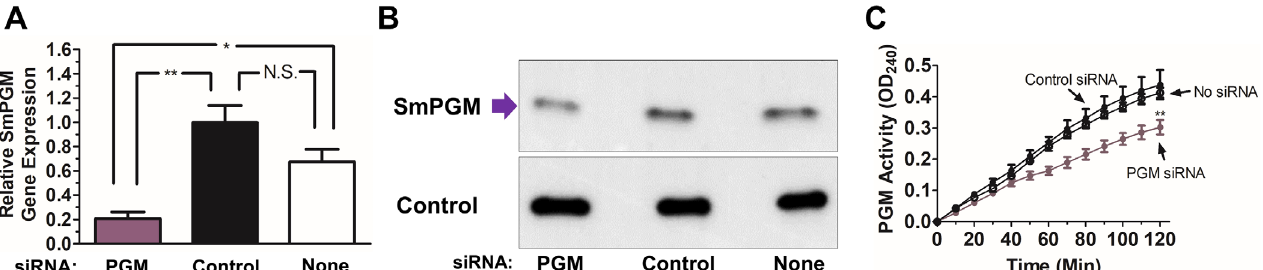
Figure 3. SmPGM gene suppression using RNA interference. (A) Relative SmPGM gene expression in schistosomula 72 h after electroporation with siRNA targeting SmPGM (purple bar, PGM), control siRNA (black bar, Control) or no siRNA (white bar, None) as assessed by RT-qPCR. Signi fi cant differences are denoted by * p < 0.05, ** p < 0.01 (one-way ANOVA with Tukey ’ s post-test). (B) Western blot analysis of SmPGM protein (purple arrow) in schistosomula lysates 7 days after electroporation with siRNA targeting SmPGM (left), control siRNA (middle), or no siRNA (right) as indicated. Blots were probed with anti-GAPDH monoclonal antibody (lower panel, Control) to show that all lanes received roughly equivalent amounts of protein. (C) Mean SmPGM activity in live schistosomula tested 7 days after electroporation with siRNA targeting SmPGM (purple line), control siRNA (black line, fi lled circles), or no siRNA (black line, empty circles). Signi fi cant differences for all time points after 70 min are denoted by ** p < 0.01 (two-way ANOVA with Bonferroni